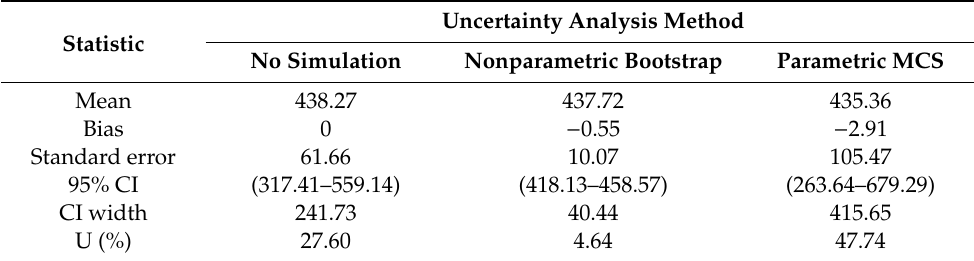
Table 5. Uncertainty of GHG emissions of the three uncertainty analysis methods: no